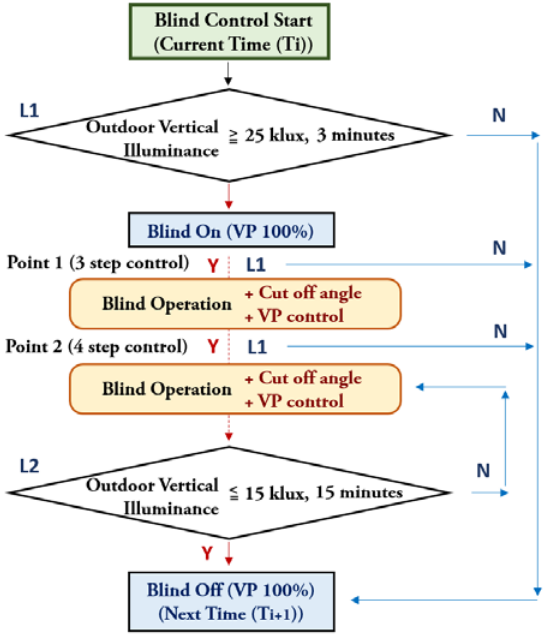
Figure 9. Outdoor vertical Illuminance-based automatic blind control logic.